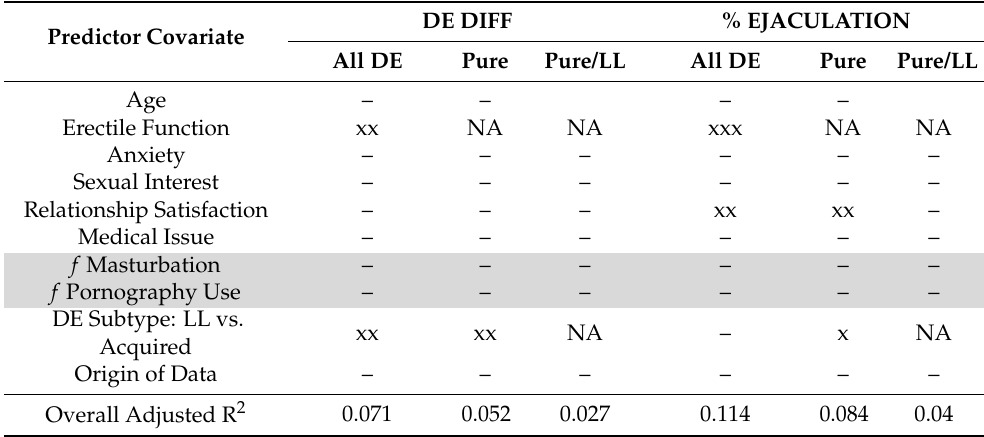
Table 6. Patterns of variable associations in the subset of men having DE symptoms, showing the lack of significant association between frequency of masturbation or pornography use (both grey-shaded for emphasis), and DE severity 1